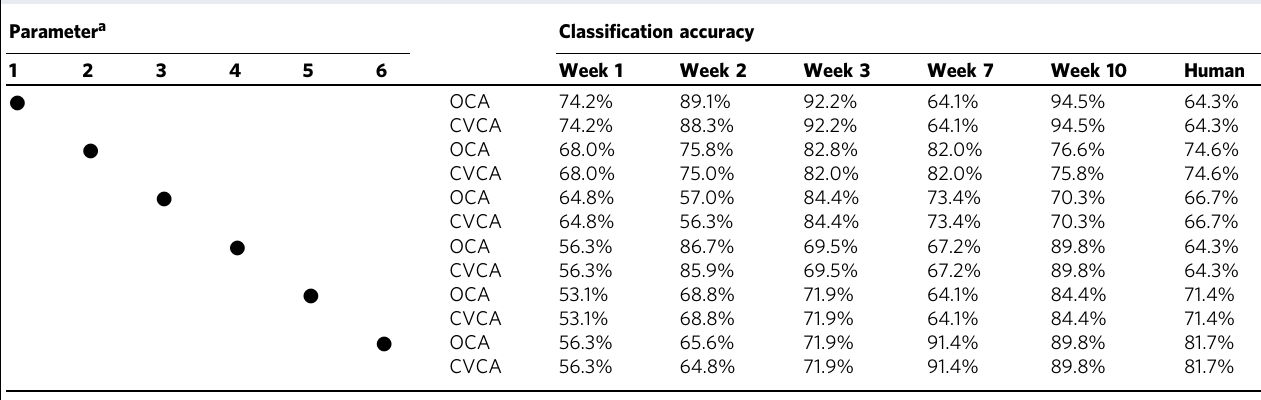
Table 1 Classi fi cation accuracy between DMM (OA) and sham (normal) using a single optical